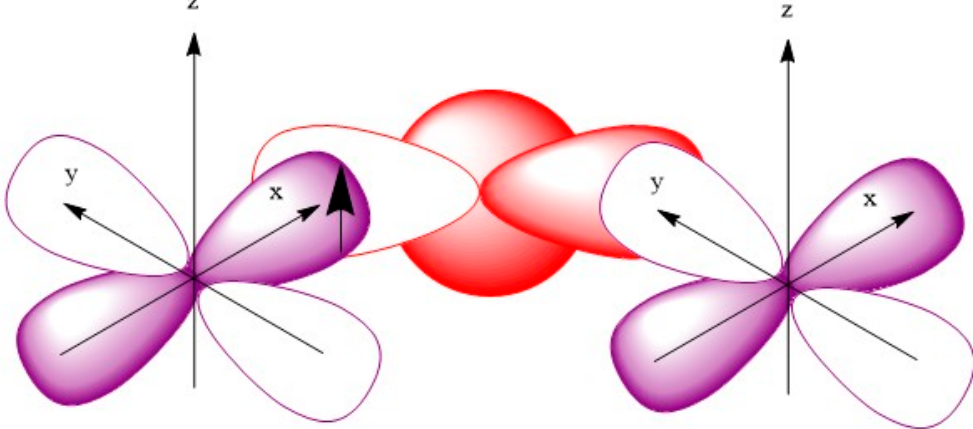
Figure 5. χ M T vs. T plot under a magnetic field of 1000 G in the 5~300 K range for compound 2 . The black squares represent experimental data, and the solid red line is the best fit to the data using Equation (1).